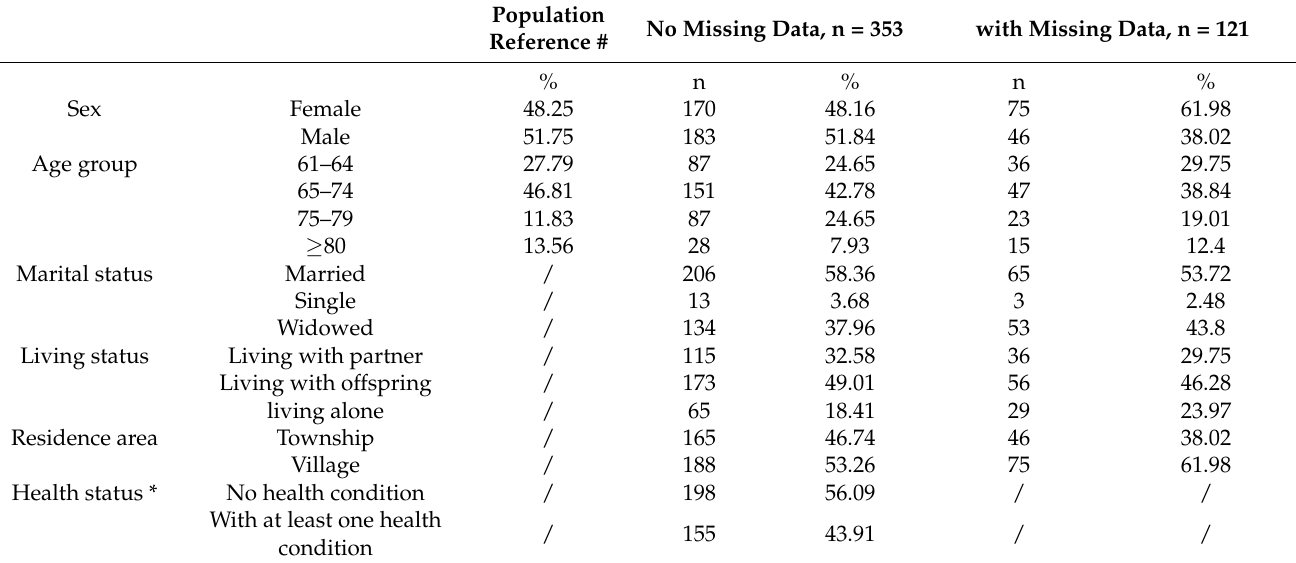
Table 1. Demographic information of the sample, n =